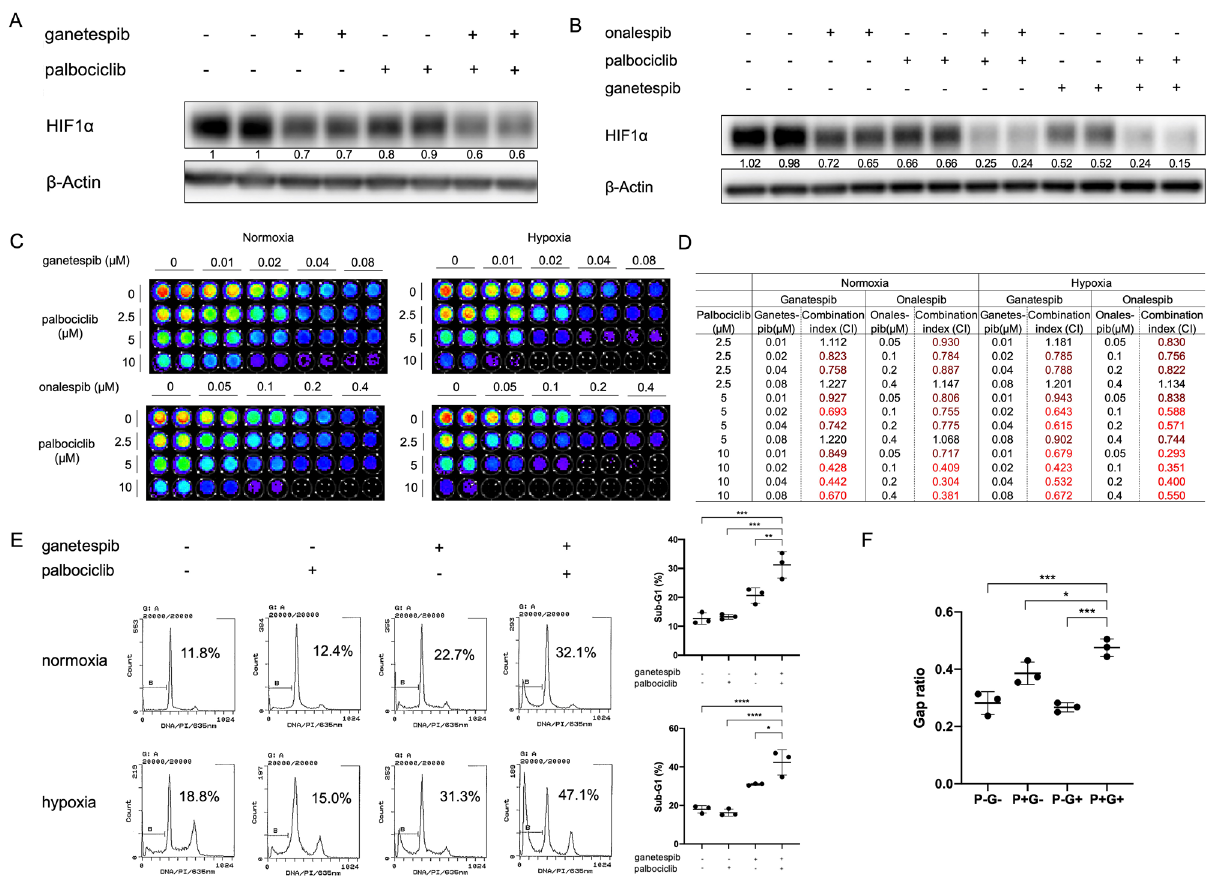
Figure 5. Dual inhibition of CDK4/6 and HSP90 reduces HIF1α in colorectal cancer cells and synergistically inhibits cell viability in HCT116. ( A ) HCT116 cells were treated with the indicated inhibitors (ganetespib at 0.05 μM and palbociclib at 10 μM) for 6 h under hypoxia (0.5% O 2 ). ( B ) SW480 cells were treated with the indicated inhibitors (ganetespib at 0.05 μM, onalespib at 0.05 μM, and palbociclib at 10 μM) for 6 h under hypoxia (0.5% O 2 ). ( C , D ) CDK4/6 inhibitor palbociclib and HSP90 inhibitor ganetespib or onalespib synergistically inhibit the viability of HCT116 cells at 72 h in normoxia and hypoxia (0.5% O 2 ). ( E ) Sub-G1 analysis by propidium iodide staining and flow cytometry for HCT116 cells treated with the indicated drug combinations (ganetespib at 0.04 μM; palbocilib at 10 μM) for 48 h. ( F ) Scratch assay in HT29 cells under CoCl 2 treatment (50μΜ) to mimic hypoxia for 72 h. (P: palbociclib; G: ganetespib.) Statistical analysis was performed using one-way ANOVA supplemented with Dunnett test. Mean ± SD was shown. * p < 0.05, ** p < 0.01, *** p < 0.001, **** p <